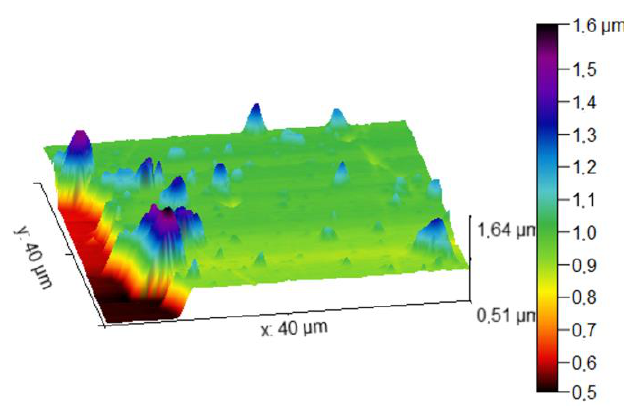
Figure 8. AFM micrograph for Bi 2 Te 3 thin film.